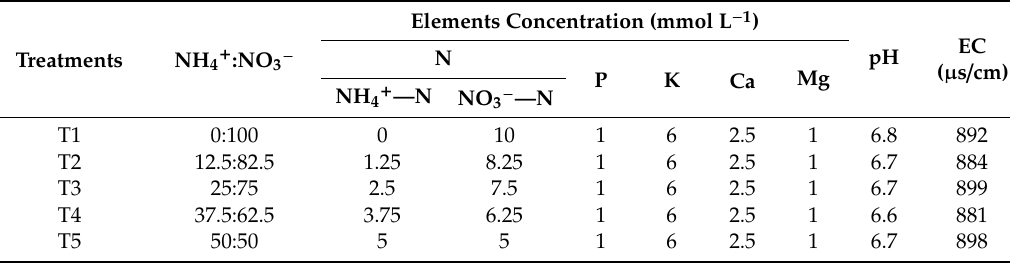
Table 2. The concentrations of elements (mM), pH, and EC in 5 nutrition